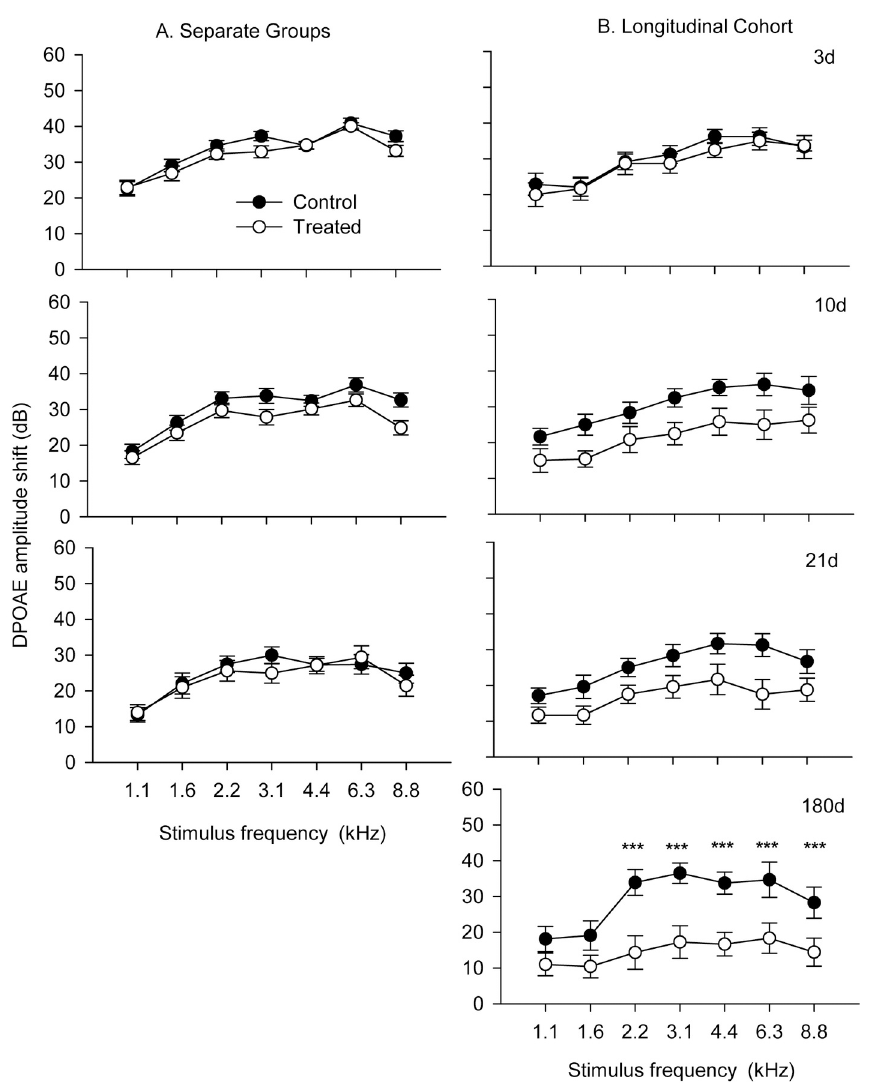
Fig 3. Distortion-product otoacoustic emission (DPOAE) amplitude shifts plotted in the same format as Fig 1. The numberof ears at each time point is the same as ABR data. The symbols with vertical bars representthe means and SEM, respectivelyof DPOAE amplitudeshifts at individualstimulus frequencies. Two-way ANOVA and Bonferroni Post Hoc test were applied.The symbols of *** indicate significance levels of p <